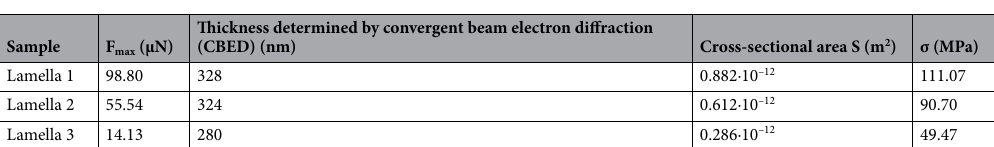
Table 1. The calculated thickness, cross-sectional area, and adhesion strength (σ) of the lamellae.